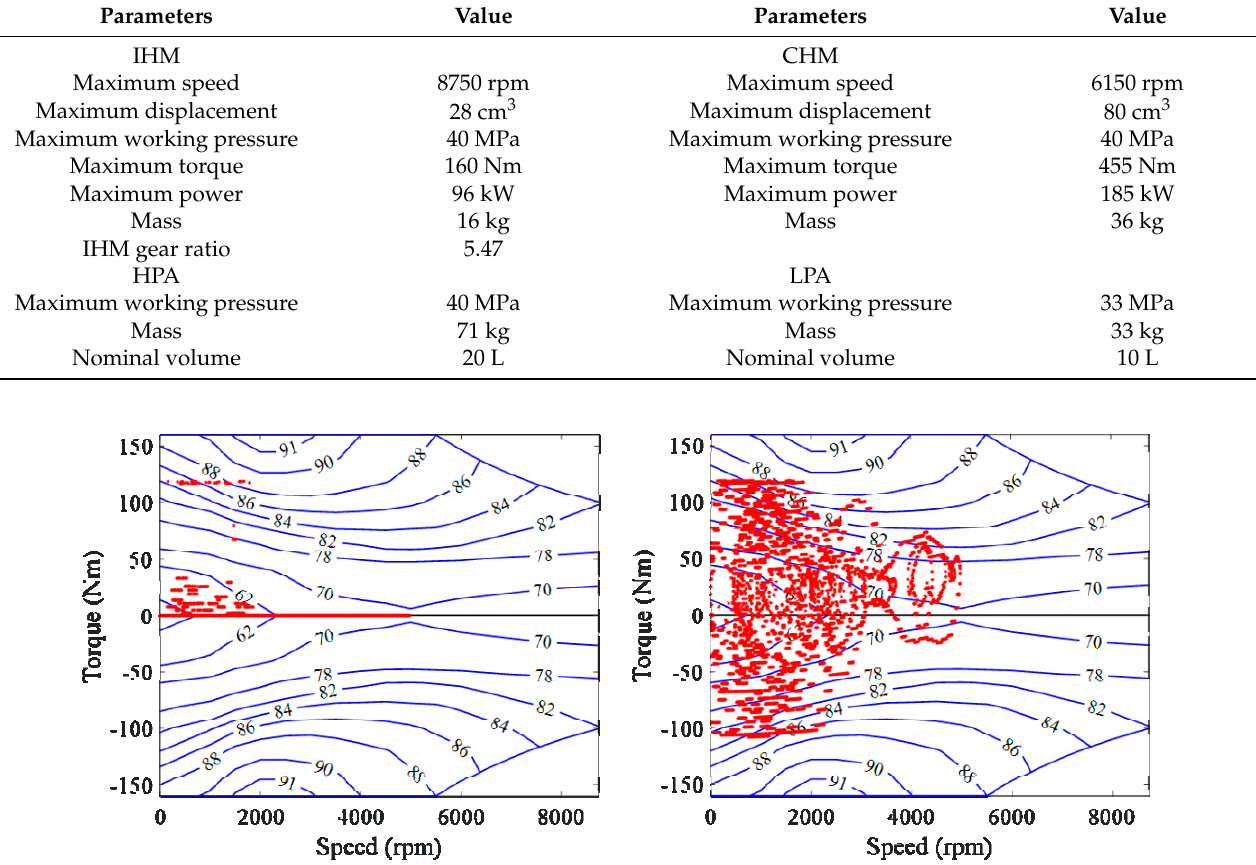
Table 3. Parameters of IHV.